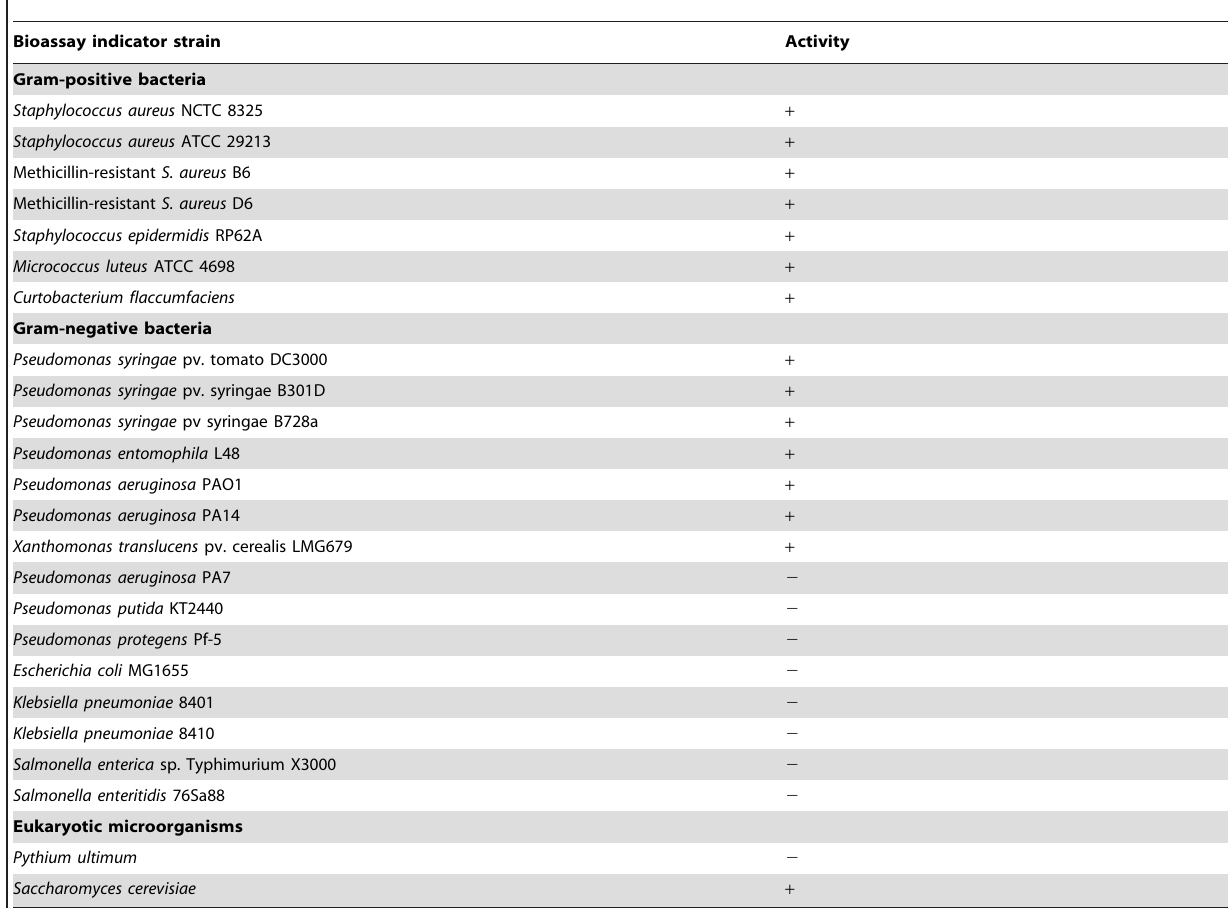
Table 3. Antagonistic activity of P. putida W15Oct28 against different microorganisms.